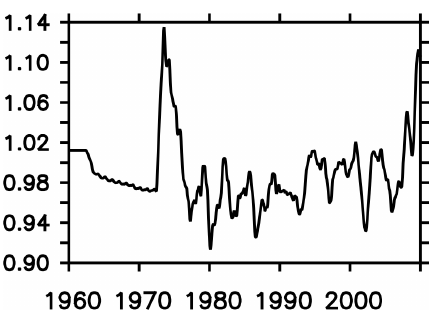
Figure 22. Observational estimate of annual mean sea ice cover south of 40 ◦ S in units of 10 7 km 2 calculated from HadISST (Rayner et al., 2003).